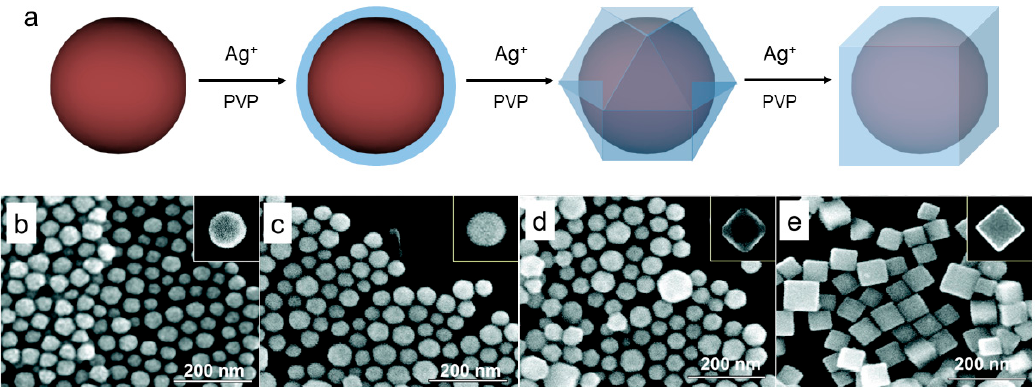
Figure 9. Schematic illustration of ( a ) Au@Ag core–shell nanopolyhedrons synthesized by the seed-mediated method and SEM images of ( b ) gold nanoseeds, ( c ) Au@Ag nanospheres, ( d ) Au@Ag cuboctahedrons, and ( e ) Au@Ag nanocubes. Reproduced with permission from ref. [74]. Copyright 2011 American Chemical Society.